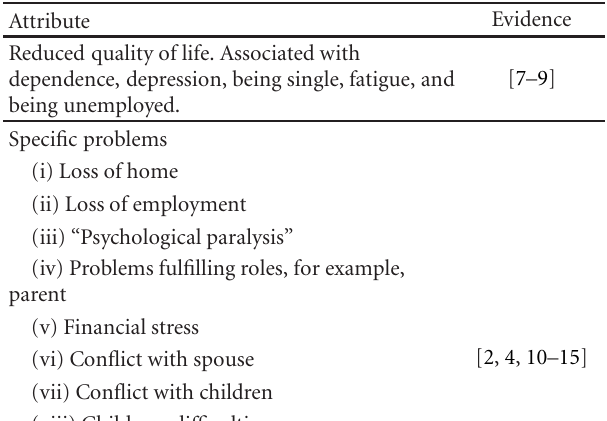
Table 1: Psychological adjustment in young stroke survivors. Attribute Evidence Reduced quality of life. Associated with dependence, depression, being single, fatigue, and being